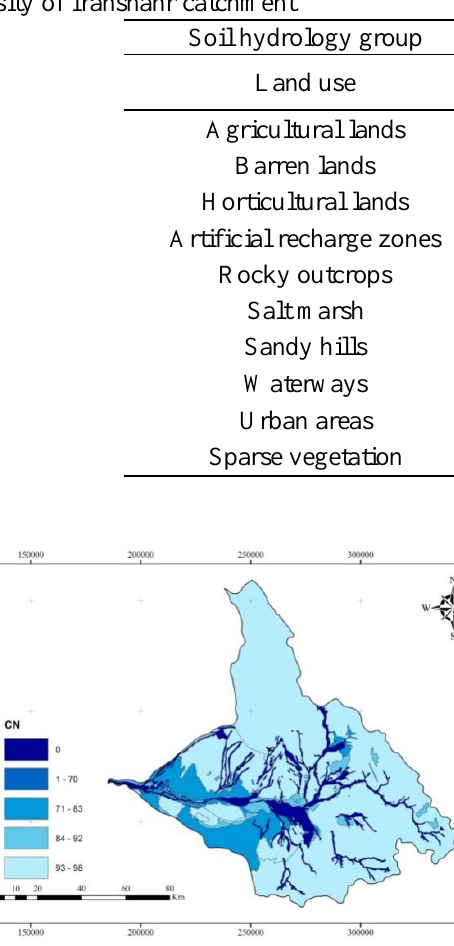
Figure 11. vegetation density map of Iranshahr Figure 10. Curve Number map of Iranshahr